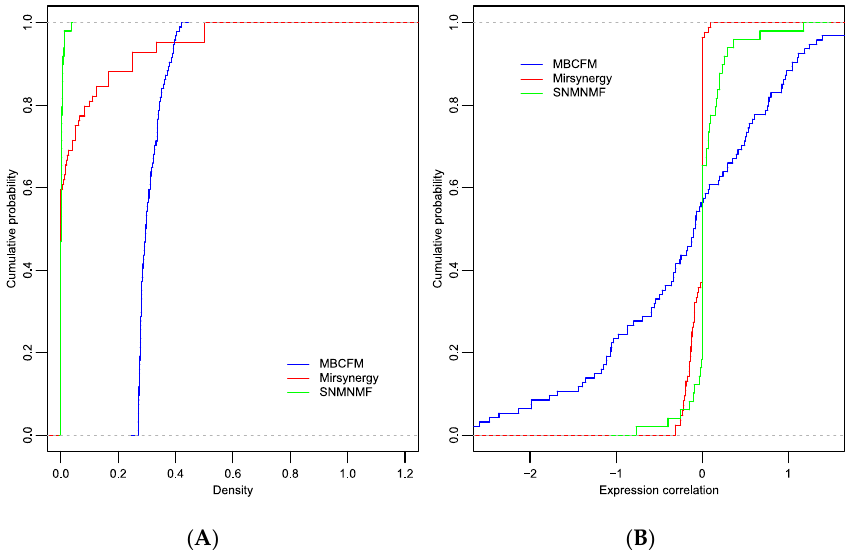
Figure 3. The cumulative distribution function (CDF) for the density and miMEC of modules identified by MBCFM, Mirsynergy and SNMNMF on ovarian dataset. ( A ) There are plenty of zero-density modules identified by Mirsynergy and SNMNMF; ( B ) MBCFM can collect lots of negative anti-correlation modules in which the correlation values are less than − 1, while other two methods only can collect a few of modules whose correlation values are between 0 and − 1.